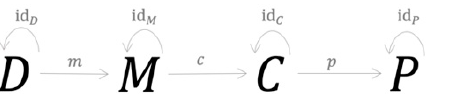
Figure 2. Category R of the modeling process underlying current Figure 2. Category 𝑅 of the modeling process underlying current approaches. Figure 2. Category 𝑅 of the modeling process underlying current approaches.